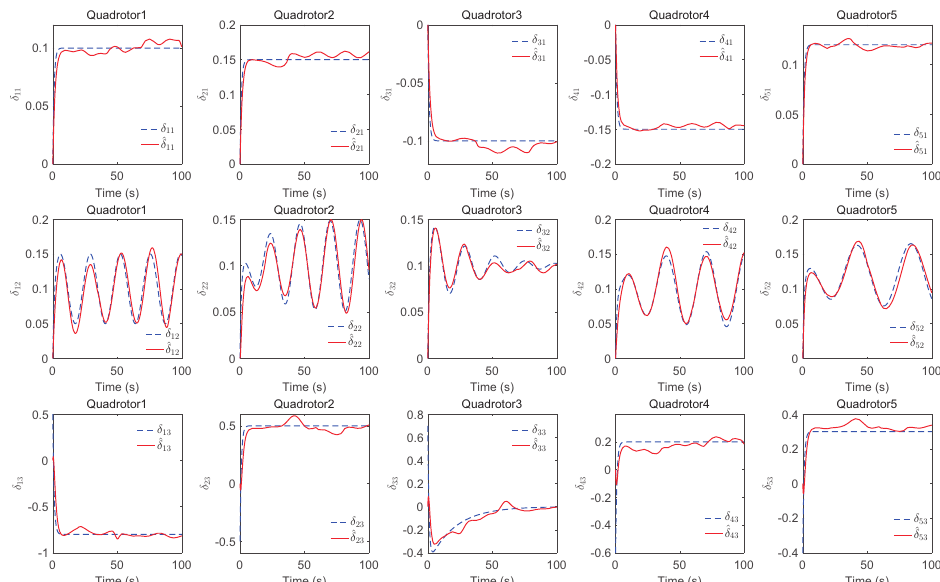
Figure 14. Estimation of additive